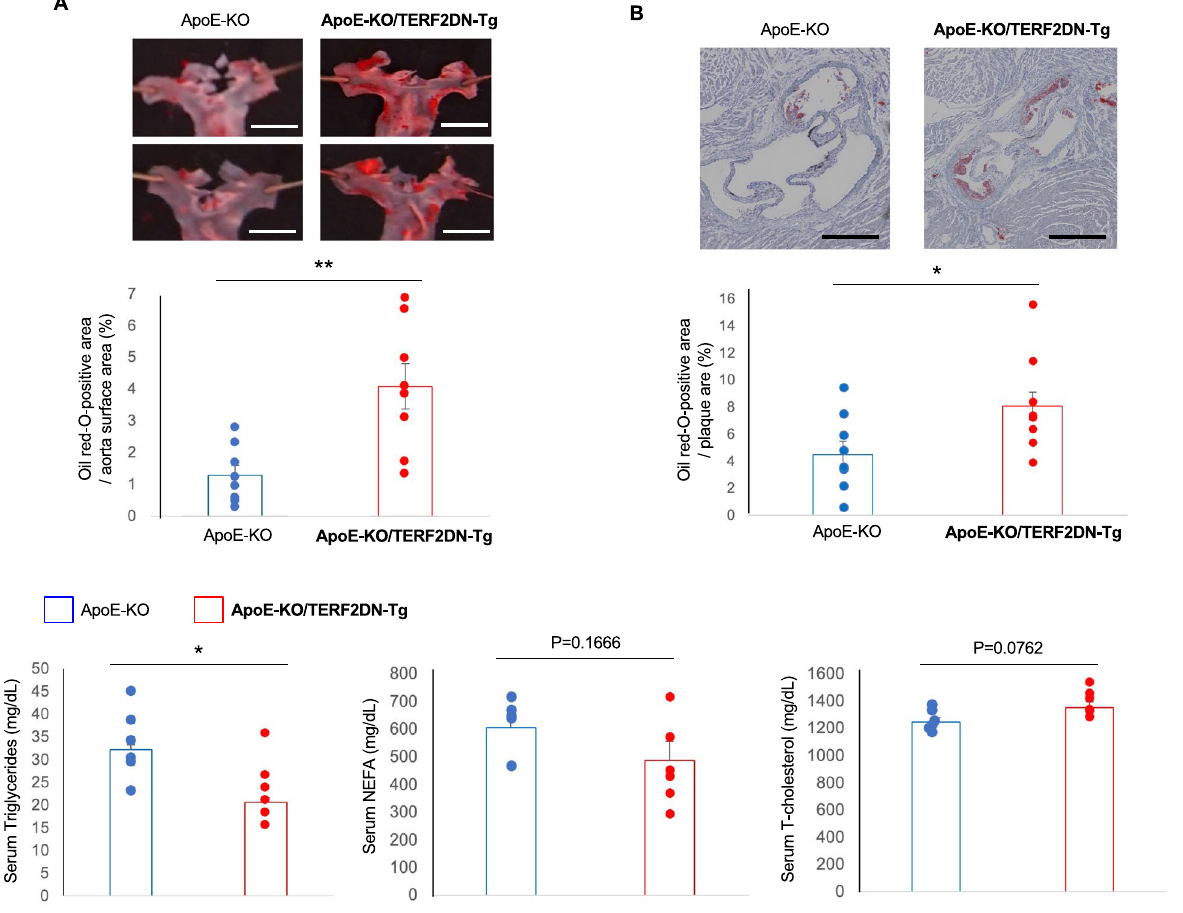
Figure 1. Atherosclerosis was accelerated in EC-specific progeroid mice. ( A ) Typical images for oil red-O staining of enface thoracic aorta isolated from ApoE-KO and ApoE-KO/Tie2-TERF2DN-Tg mice fed high cholesterol diet for 2 weeks are shown. Atherosclerotic plaque was augmented in EC-specific progeroid mice as compared to that in littermate ApoE-KO mice (n = 8 each). Bars: 2 mm. ( B ) Representative images of oil red-O 500 μm. ( C ) Serum lipid profiles in ApoE-KO and ApoE-KO/Tie2-TERF2DN-Tg mice fed high cholesterol diet for 2 weeks (n = 6 each). Data are presented as mean ± SEM. * p < 0.05 and ** p <